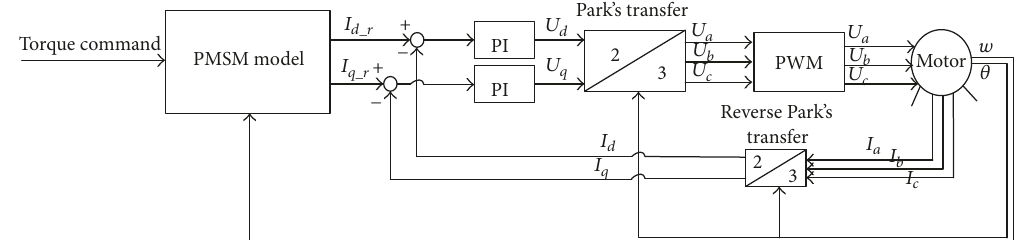
Figure 6: Control logic of permanent magnet synchronous motor.